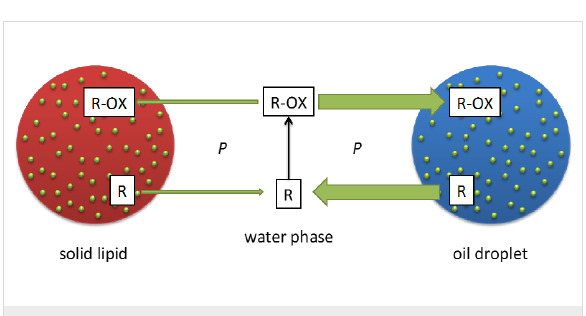
Figure 4: Fast degradation of lipophilic active agents (R) in fluid carriers (blue), such as oil/water emulsions or creams and liposomes, through fast exchange with the water phase (right) in comparison to a minimized exchange of active between a highly viscous solid carrier (red) and the water phase (left) ( P : partitioning coefficient); modified with permission from [17], copyright 2017 Elsevier.